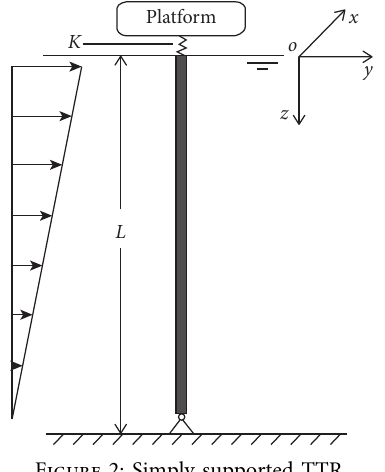
Figure 2: Simply supported